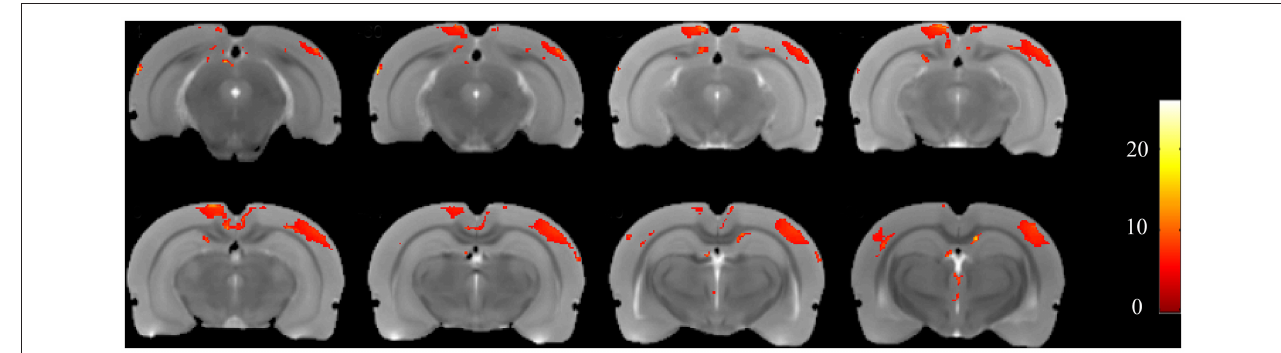
FIGURE 5 | F-maps of the gray matter volume (GMV) from the ANOVA analysis of the CL, PTZ, and control groups. Only significant differences with a cluster size exceeding 50 ( P < 0.01) are shown. At the level of the cortex, volumetric changes were found in the retrosplenial dysgranular cortex and primary somatosensory cortex.